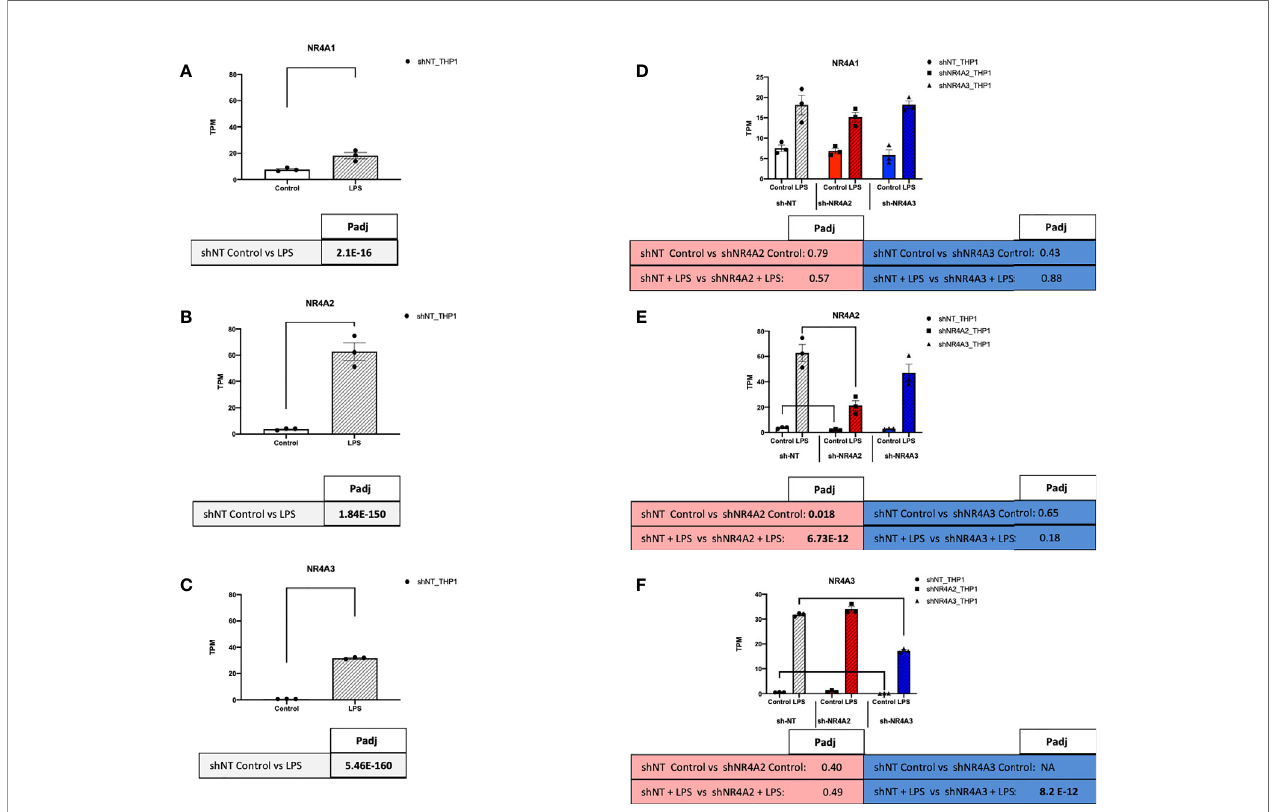
FIGURE 7 | NR4A expression and depletion in THP-1 monocytes. RAW TPM values (mean +/- SEM) extracted from RNA-seq for NR4A1 (A) NR4A2 (B) and NR4A3 (C) in shNT-THP1 cells in the control (unstimulated state) and following LPS treatment (2.5 m g/ml for 2hrs) all shown on common axis. RAW TPM values extracted from RNA-seq for NR4A1 (D) NR4A2 (E) and NR4A3 (F) in shNT-THP1 cells, shNR4A2-THP1 cells and shNR4A3-THP1 cells in the control (unstimulated state) and following LPS treatment (2.5 m g/ml for 2hrs). N=3 independent experiments. Adjusted p-values (Padj) for speci fi c comparisons are contained in the tables below the TPM data. Statistically signi fi cant Padj are denoted in bold font. Comparisons between shNR4A2 cells and control are denoted in the red boxes, comparisons between the shNR4A3 cells and control are denoted in the blue boxes. Statistically signi fi cant comparisons are further signposted using bars on the TPM